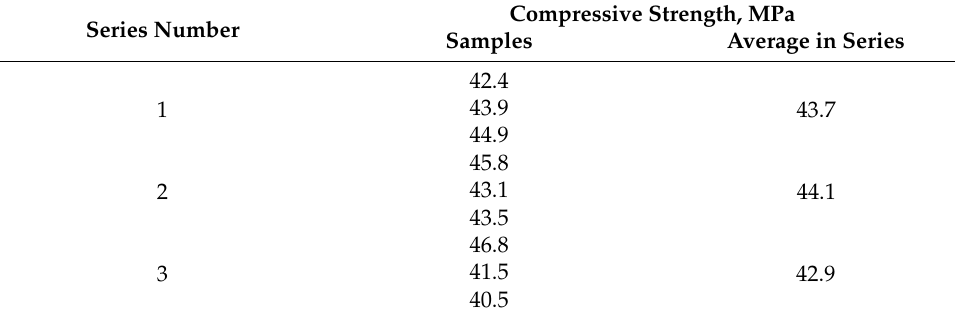
Table 9. Test results of control sample